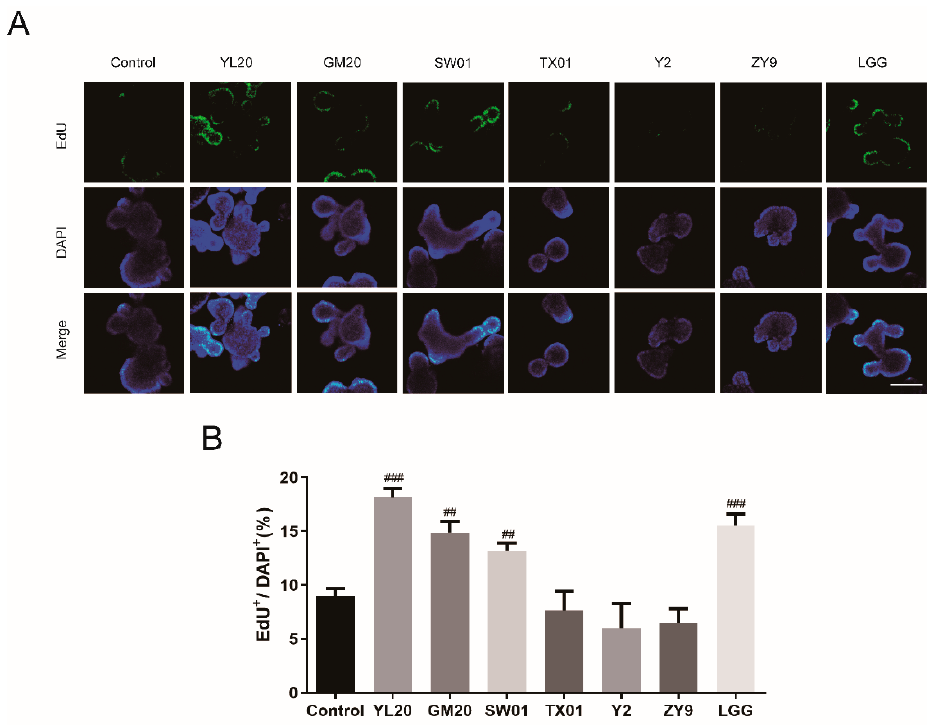
Figure 1. Effects of lactic acid bacteria on intestinal organoid proliferation. ( A ) Images of intestinal organoids stained with Hoechst33342 (blue) and EdU (green); scale bar = 50 µ m. ( B ) Percentage of EdU-positive cells calculated for different lactic acid bacteria. ## p < 0.01, ### p < 0.001 vs. Control group, n = 3.